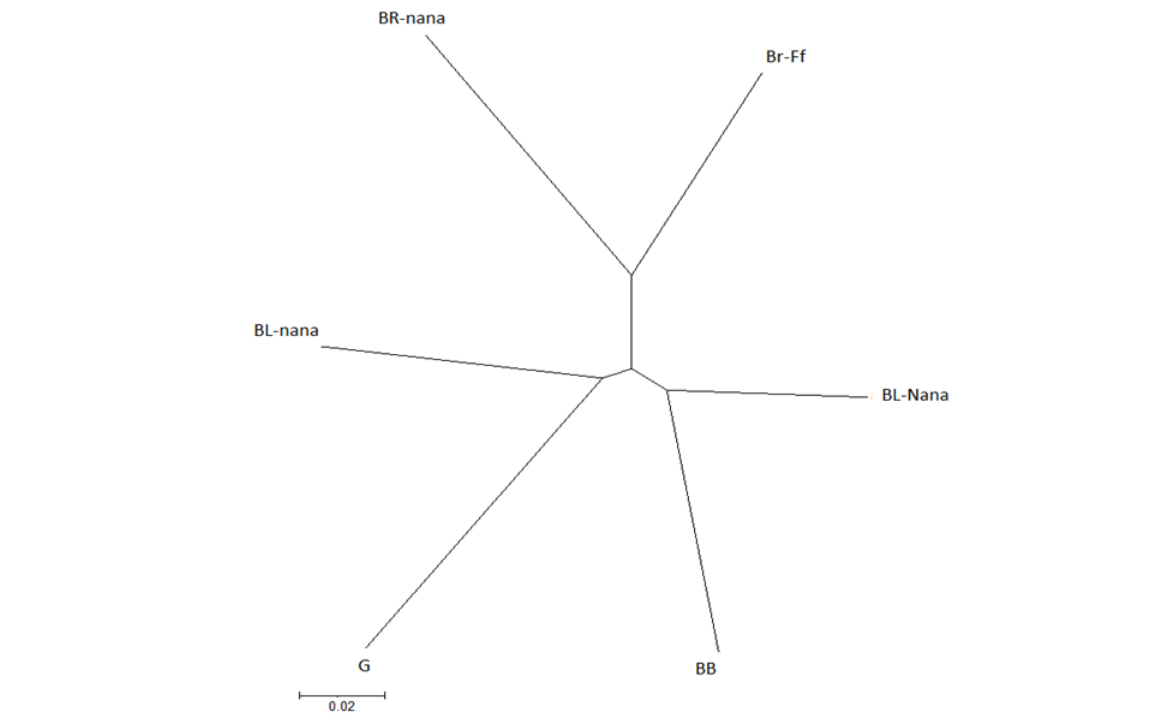
Figure 2. Unrooted neighbor-joining tree constructed using Nei’s genetic distance of Saudi native chicken